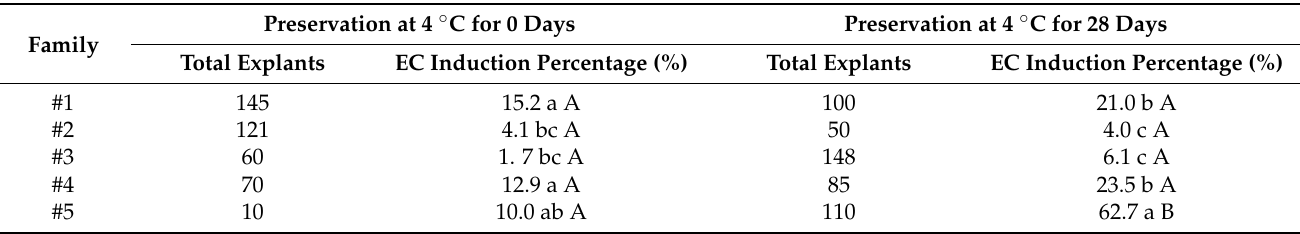
Table 2. Effects of cone pretreatment on EC induction percentage of Korean pine.